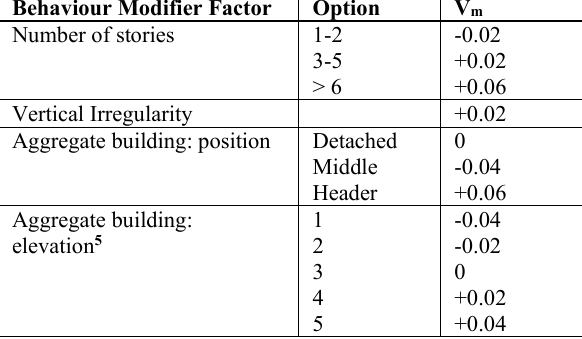
Table 5 . Behaviour modifier factors of other buildings. Source: de Vries, 2022